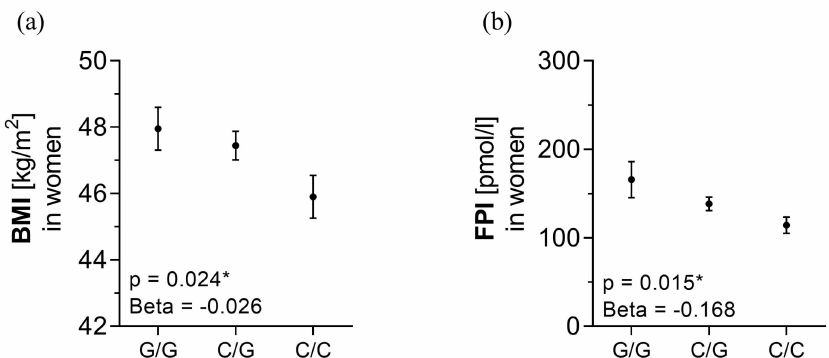
Figure 3. Association analysis of rs10487505 with ( a ) body mass index (BMI) and ( b ) fasting plasma insulin (FPI) in women. Data are shown as mean ± SEM. * p < 0.05. p adjusted for age ( a , b ) and BMI (only ( b